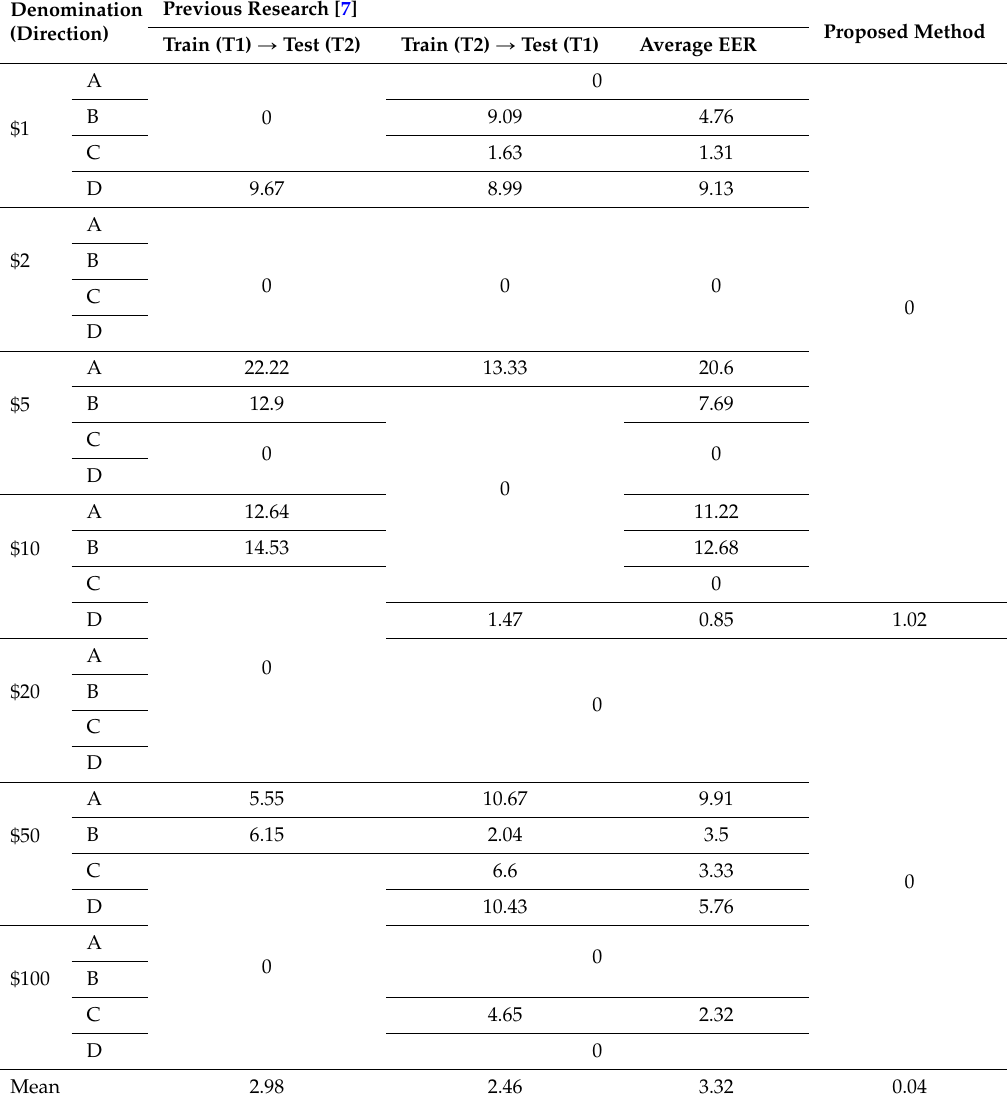
Table 6. Comparison of mean EER between the proposed method and a previous method. (unit: %). Denomination